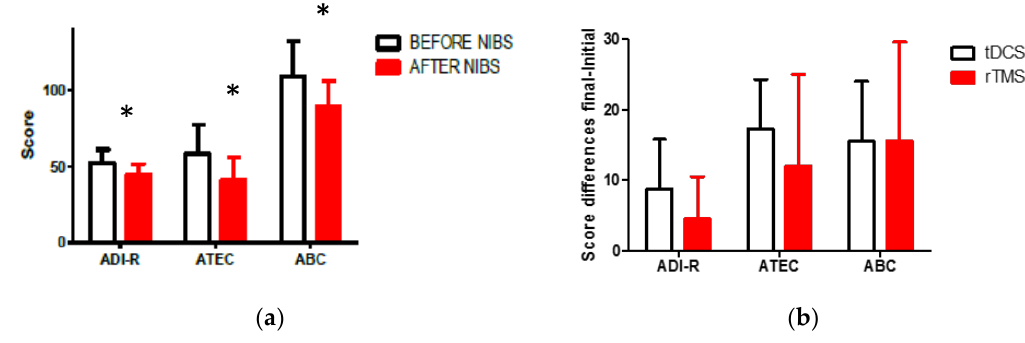
Figure 1. ( a ) Comparison of pre- intervention and one-month post-intervention scores in clinical scales; ( b ) no significant differences in the clinical effect with the use of rTMS or tDCS according to the score differences (Initial–Final) (* p < 0.05).